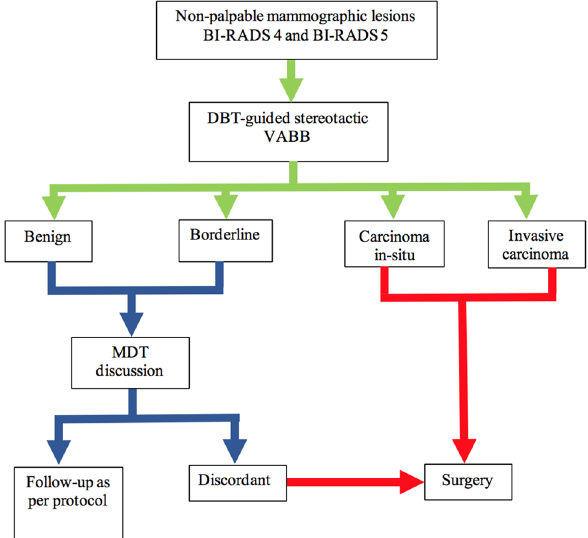
Figure 1. Flow chart of lesions and further